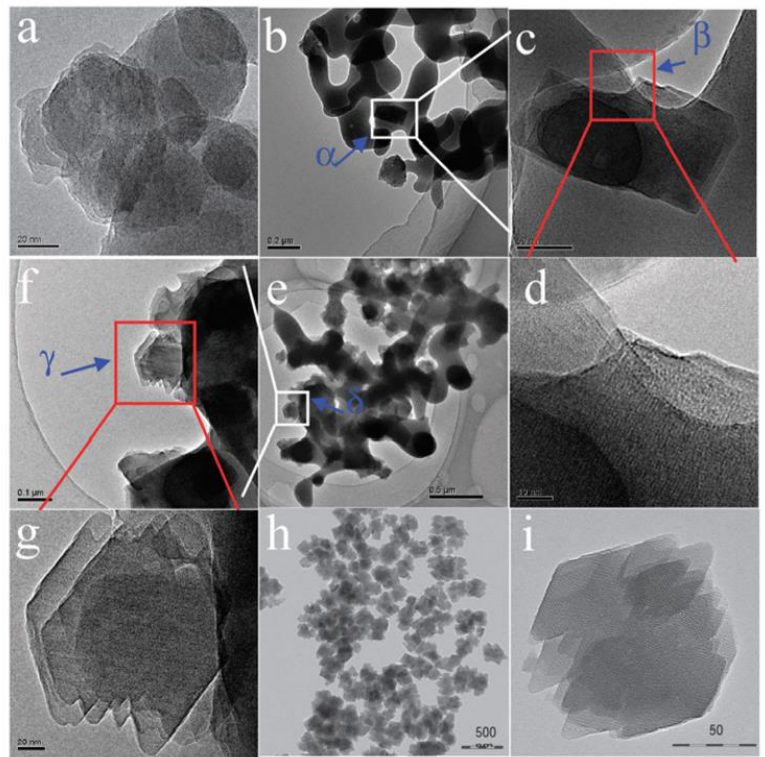
Figure 1. TEM images of Beta-OTF products crystallized for ( a ) 1, ( b – d ) 4, ( e – g ) 8 and ( h , i ) 18.5 h; areas of α , β , γ and δ in the Figure ( b , c , e , f ) are enlarged as Figure ( c , d , f , g ). Reprinted with permission from ref. [37]. Copyright 2011, The Royal Society of Chemistry.